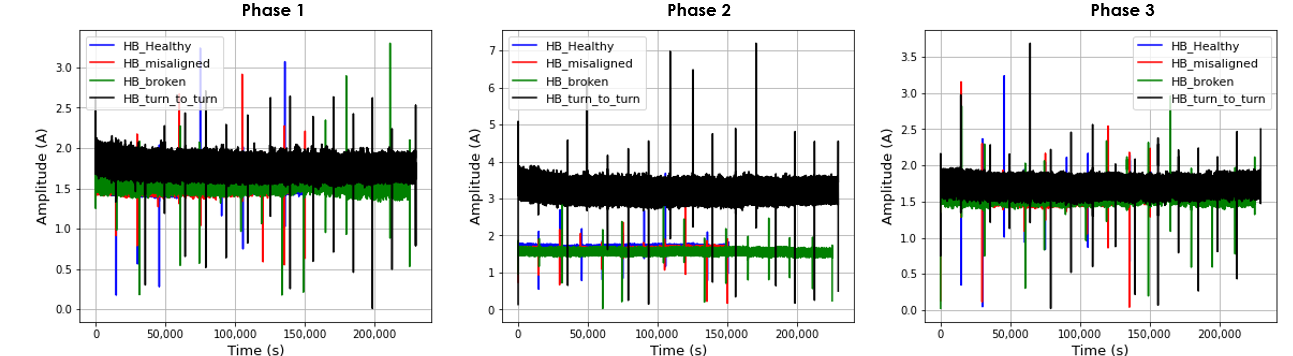
Figure 9. Magnitude envelope of the analytic